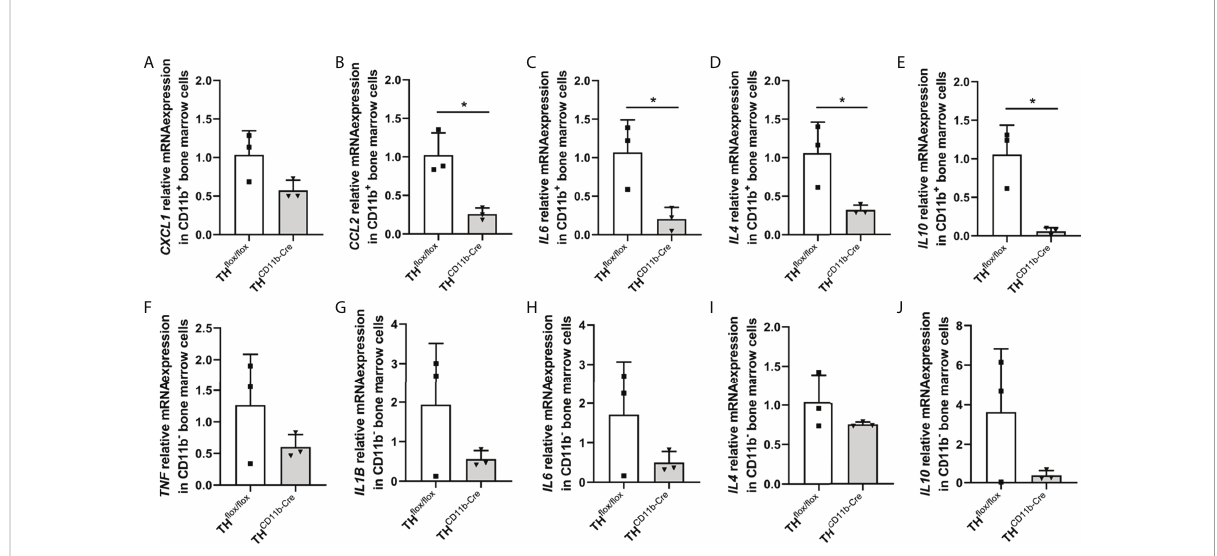
FIGURE 6 Cytokine expression in immune cells of TH CD11b-Cre mice. (A) CXCL1 , (B) CCL2 , (C) IL6 , (D) IL4 and (E) IL10 relative mRNA expression in CD11b + bone marrow cells of twelve-week-old TH fl ox/ fl ox and TH CD11b-Cre mice. (F) TNF , (G) IL1B , (H) IL6 , (I) IL4 and (J) IL10 relative mRNA expression in CD11b - bone marrow cells of twelve-week-old TH fl ox/ fl ox and TH CD11b-Cre mice. n = 3; *P <